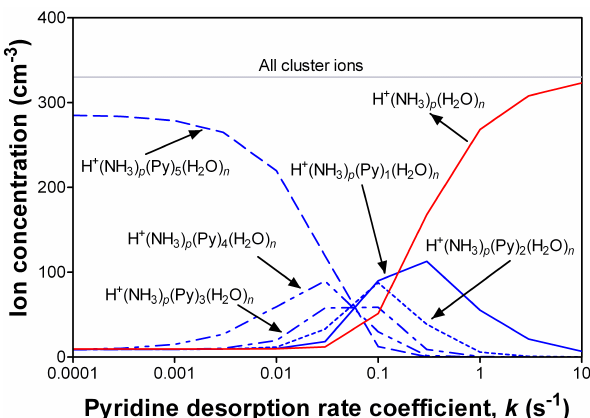
Fig. 9. Concentrations of the most abundant cluster ions as a func- tion of pyridine desorption rate coefficient. The values were calcu- lated using Model B with inclusion of evaporation of pyridine. The initial concentrations are given in Table 2 except the concentration of pyridine that was kept at 9.84 × 10 7 cm − 3